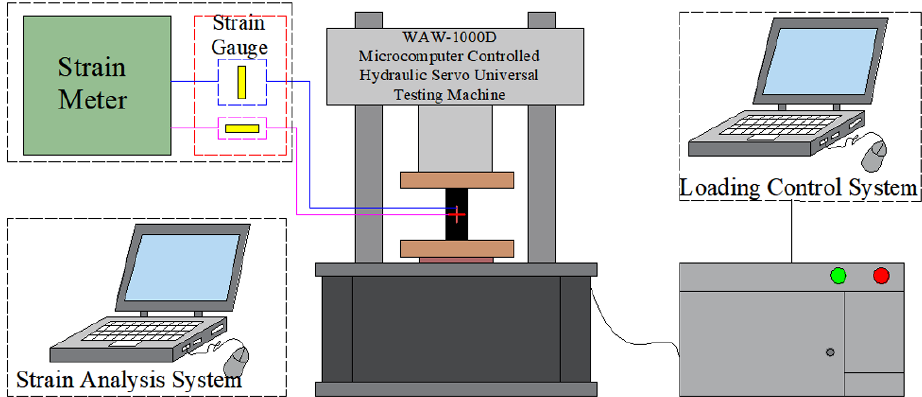
Figure 4. The schematic diagram of the test system.